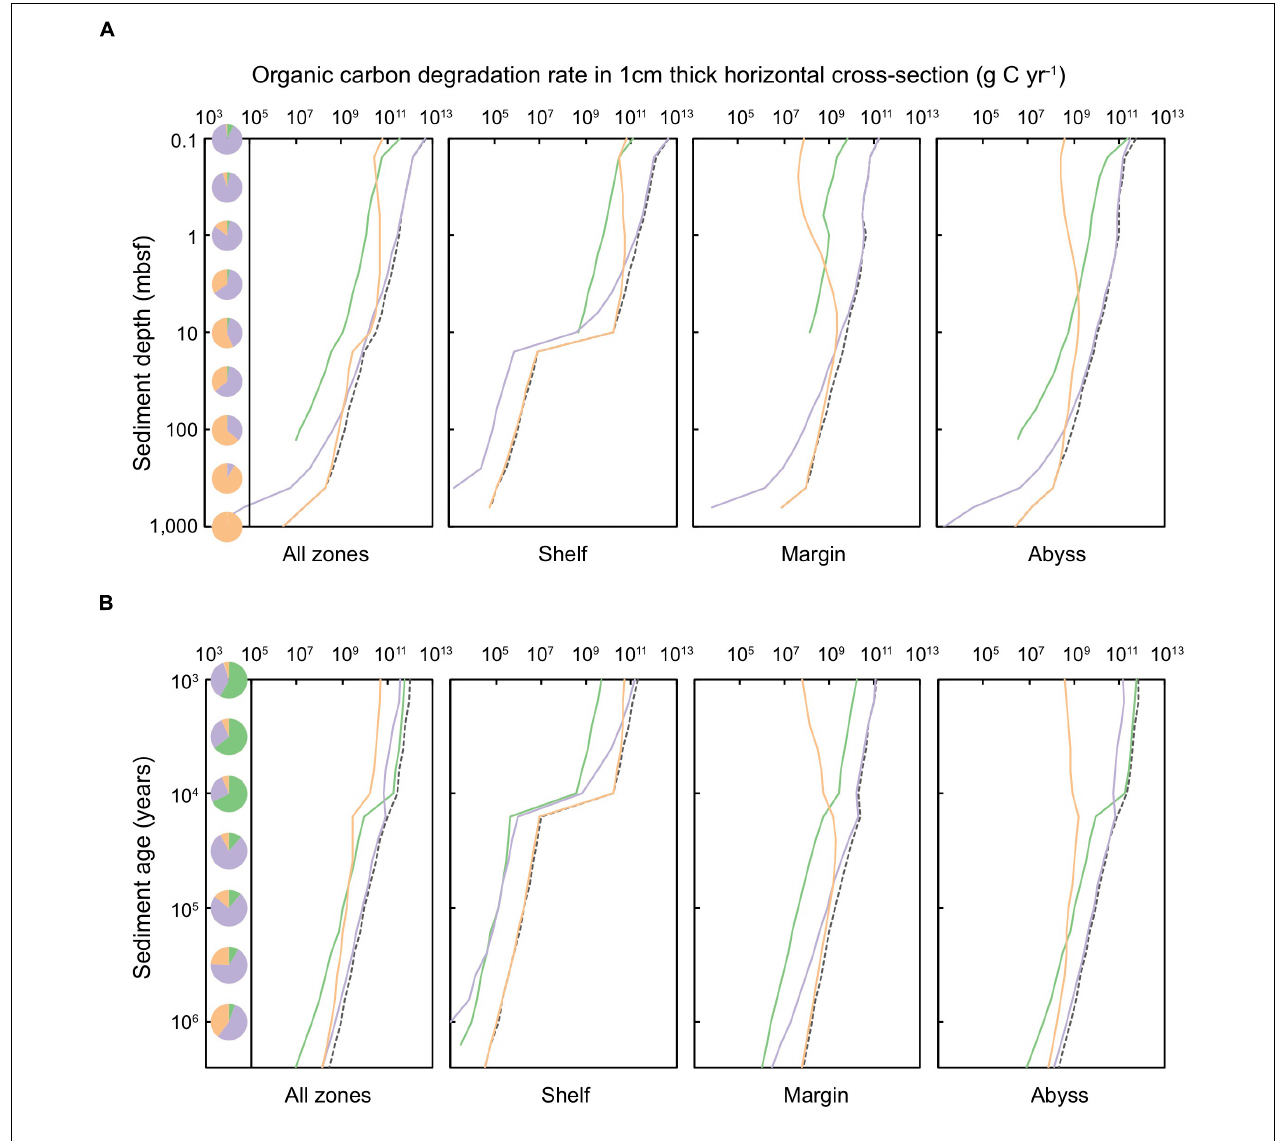
FIGURE 5 | Organic carbon degradation rate in a 1 cm thick layer of global marine sediments deposited up to 2.59 million years ago, according to equal (A) sediment depth (shown for sediments at 0.1 to ∼ 10,000 mbsf) and (B) sediment age (1,000 years to 2.59 million years). The dashed black line represents the total organic carbon degradation rate in specific depth or age layers. Shading of solid lines indicates the organic carbon degraded in sediments of a specific redox-state: green shading represents oxic sediments, lilac denotes sulfate-reducing sediments, and orange signifies methanogenic sediments. Pie charts indicate the proportion of total POC that is degraded in oxic, sulfate-reducing, and methanogenic settings for a specific (A) depth or (B) age